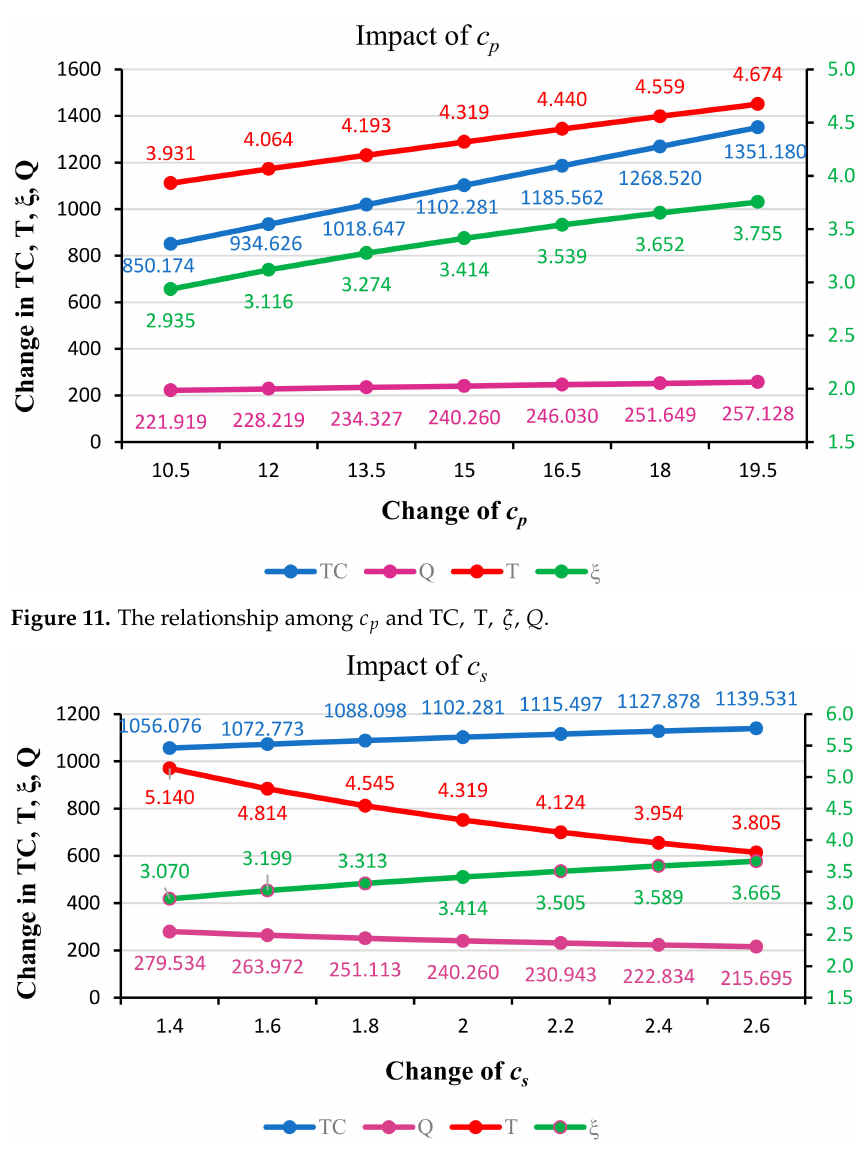
Figure 12. The relationship among c s and TC, T, ξ , Q .